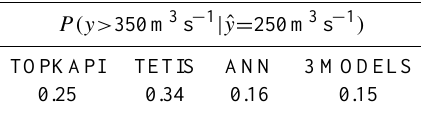
Table 1. Probability that the true value exceeds the 350m 3 s − 1 threshold when the expected value of prediction equals 250m 3 s − 1 , computed for each model and their Bayesian